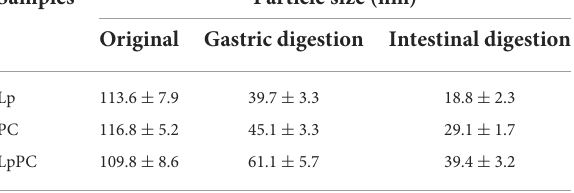
TABLE 2 Particle sizes distribution of glycated BSA after gastrointestinal